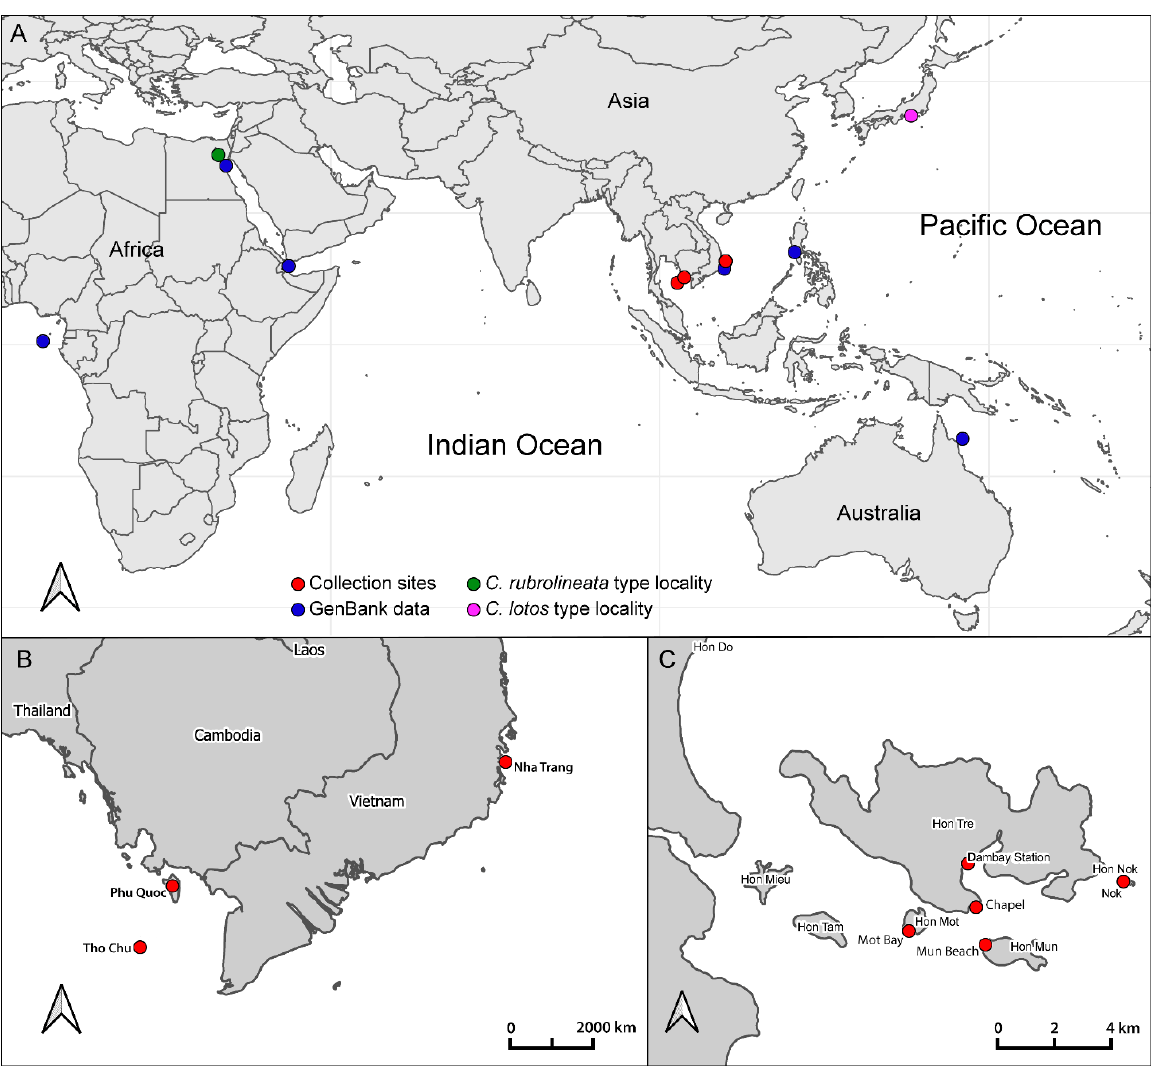
Figure 1. Collection sites of the studied material. ( A )—Global map of the Pacific and Indian oceans with collection sites (red circles) and collection sites of samples from GenBank (blue circles). Green and magenta circles indicate the type localities of Coryphellina rubrolineata and C. lotos, respectively. ( B )—Map of Southern and Central Vietnam. ( C )—Map of collection sites in Nha Trang Bay.